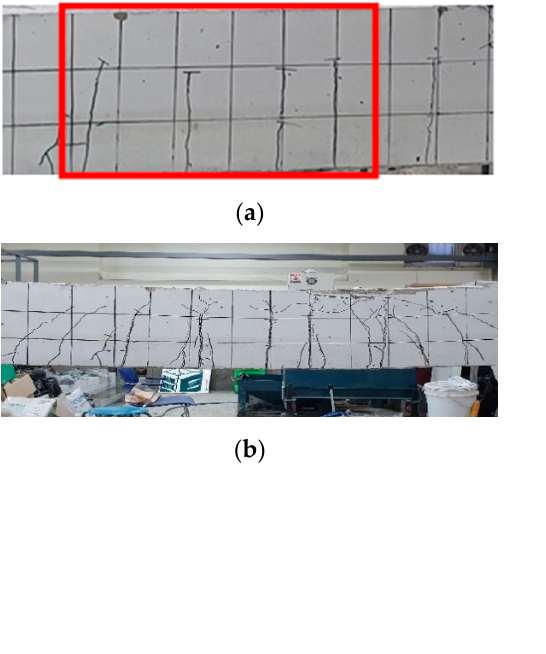
Figure 22. Crack healing of member RL_28 + 90D-2.5: ( a ) after pre-loading at 28 days + 90 days of additional curing; ( b ) after loading at 28 + 90 days; ( c ) enlargement of cracks after completion of test.